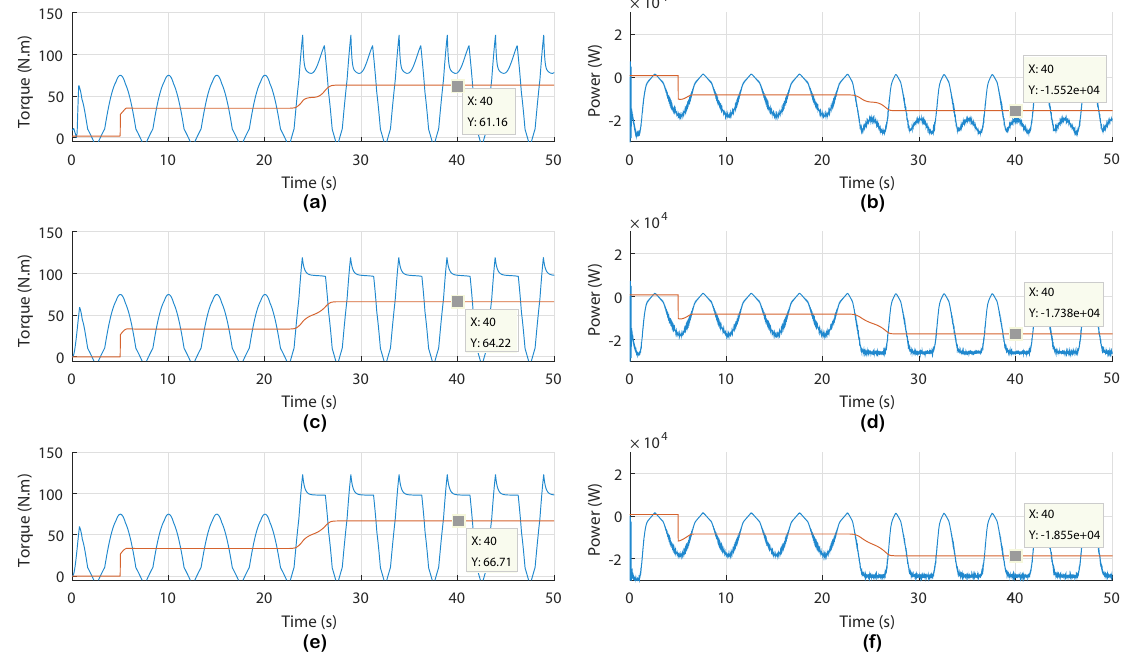
Figure 16. OWC torque and power outputs. ( a ) Torque in the uncontrolled case, ( b ) Power in the uncontrolled case, ( c ) Torque with ZN-PID, ( d ) Power with ZN-PID, ( e ) Torque with SGHS-PID, ( f ) Power with